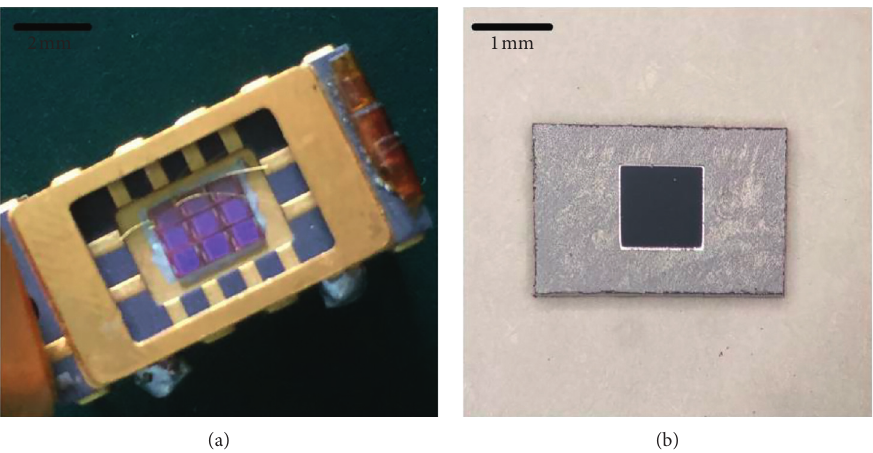
Figure 8: (a) Chip after slotted. (b) Sample of the finished package.